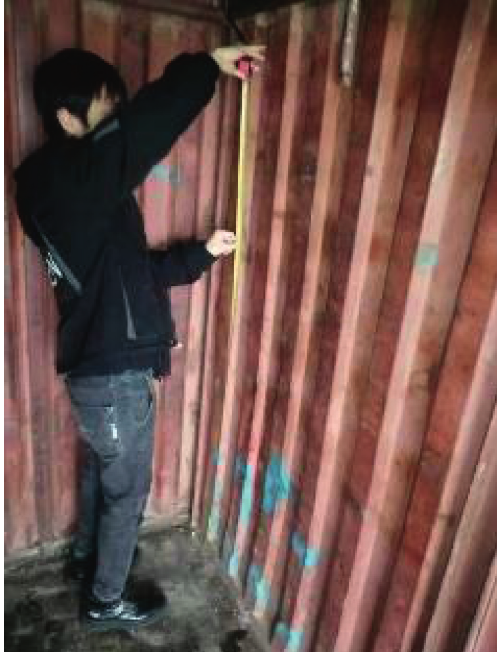
Figure 12: Parameter determination